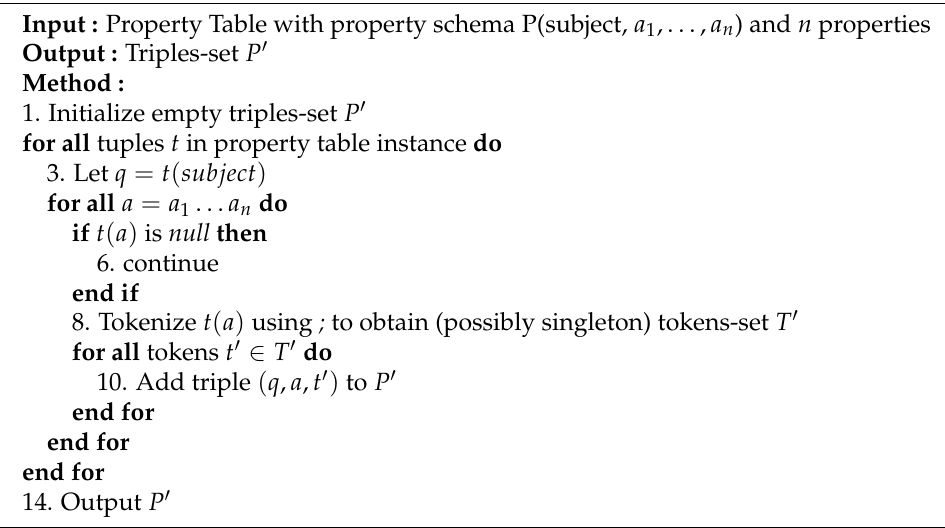
Algorithm A1 RDF Property Table to RDF